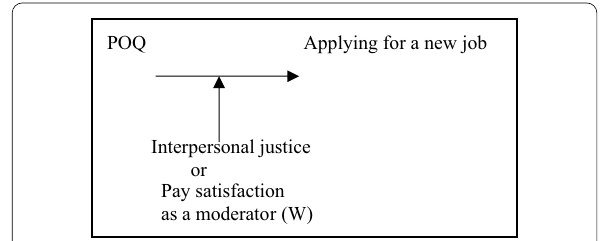
Fig. 3 Conceptual model for the direct effect of POQ on applying a new job moderated by interpersonal justice (or pay